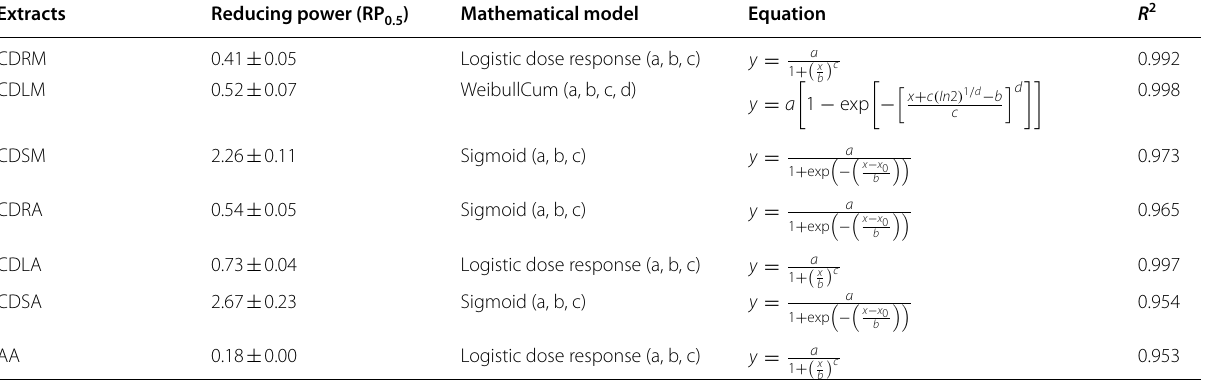
CDRM, C. dependens root methanol; CDLM, C. dependens leaves methanol; CDSM, C. dependens stem methanol; CDRA, C. dependens root aqueous; CDLA, C. dependens leaves aqueous; CDSA, C. dependens stem aqueous; AA, ascorbic acid